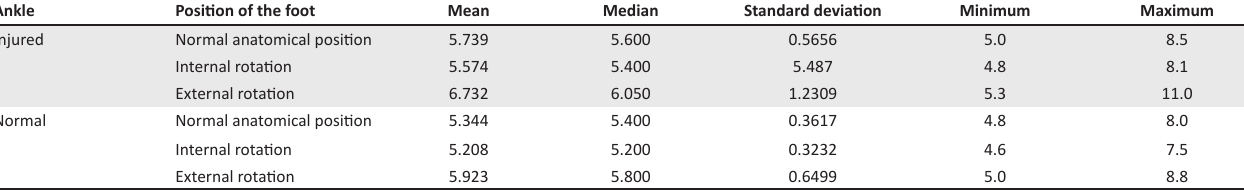
TABLE 4: Ultrasound measurements of the tibiofibular clear space in